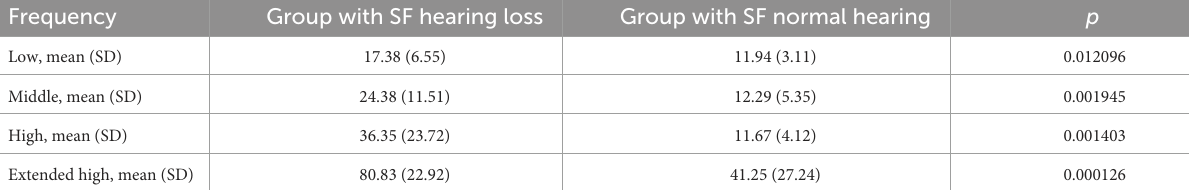
TABLE 4 The frequency characteristics of hearing threshold in patients with VM with SF normal hearing and patients with SF hearing loss. Frequency Group with SF hearing loss